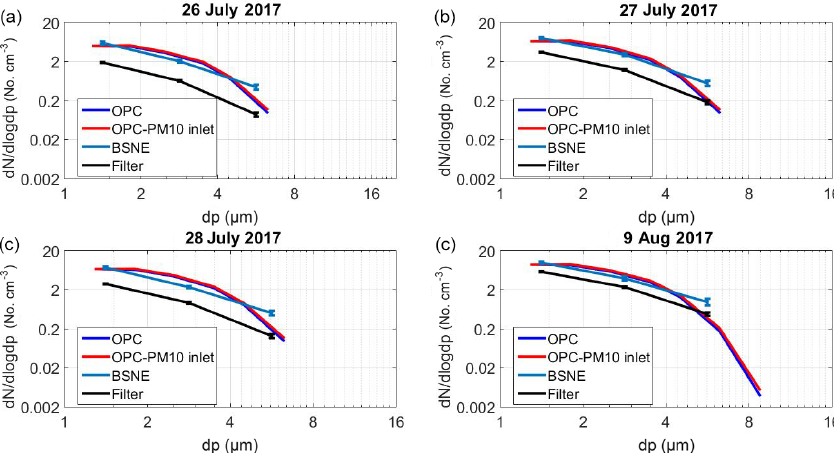
Figure 13. Average size distributions obtained from the SEM analysis of the filter sampler, in comparison to BSNE and OPC for different measurement days: (a) 26 July 2017; (b) 27 July 2017; (c) 28 July 2017; (d) 29 July 2017. Number concentration size distributions from deposition are obtained by converting the SEM-obtained number deposition rates to number concentration using different deposition velocity models. The red curve shows the OPC with PM 10 inlet efficiency correction (representing the atmospheric concentration). The number concentration measurements shown for the filter sampler are daily averages. The bars show the central 95% confidence interval of the daily variation.